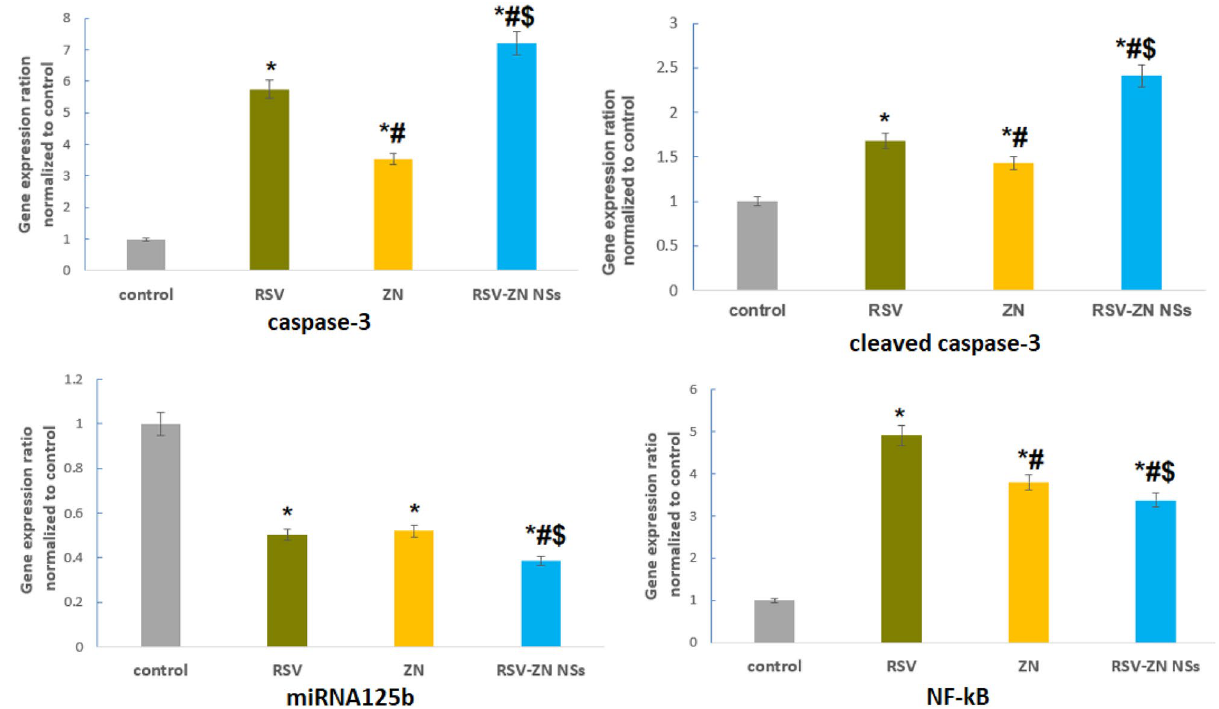
Figure 8. Impact of ZN-RSV NPs on caspase-3, cleaved caspase-3 miRNA125b and NF-κB in HCT-116 cells. *Significantly different in comparison with control ( p < 0.05). # Significantly different in comparison with RSV ( p < 0.05). $ Significantly different in comparison with ZN ( p <